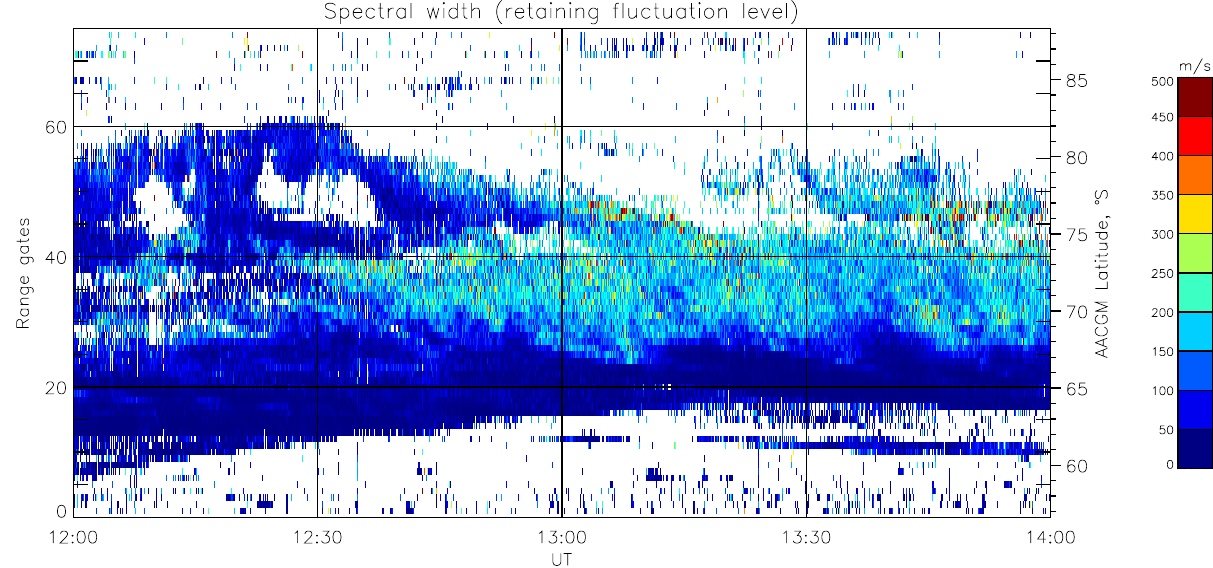
Fig. 6. The same data as Fig. 5 but without extracting the fluctuation level σ R from the ACF power | R(τ) | before the curve fitting process.